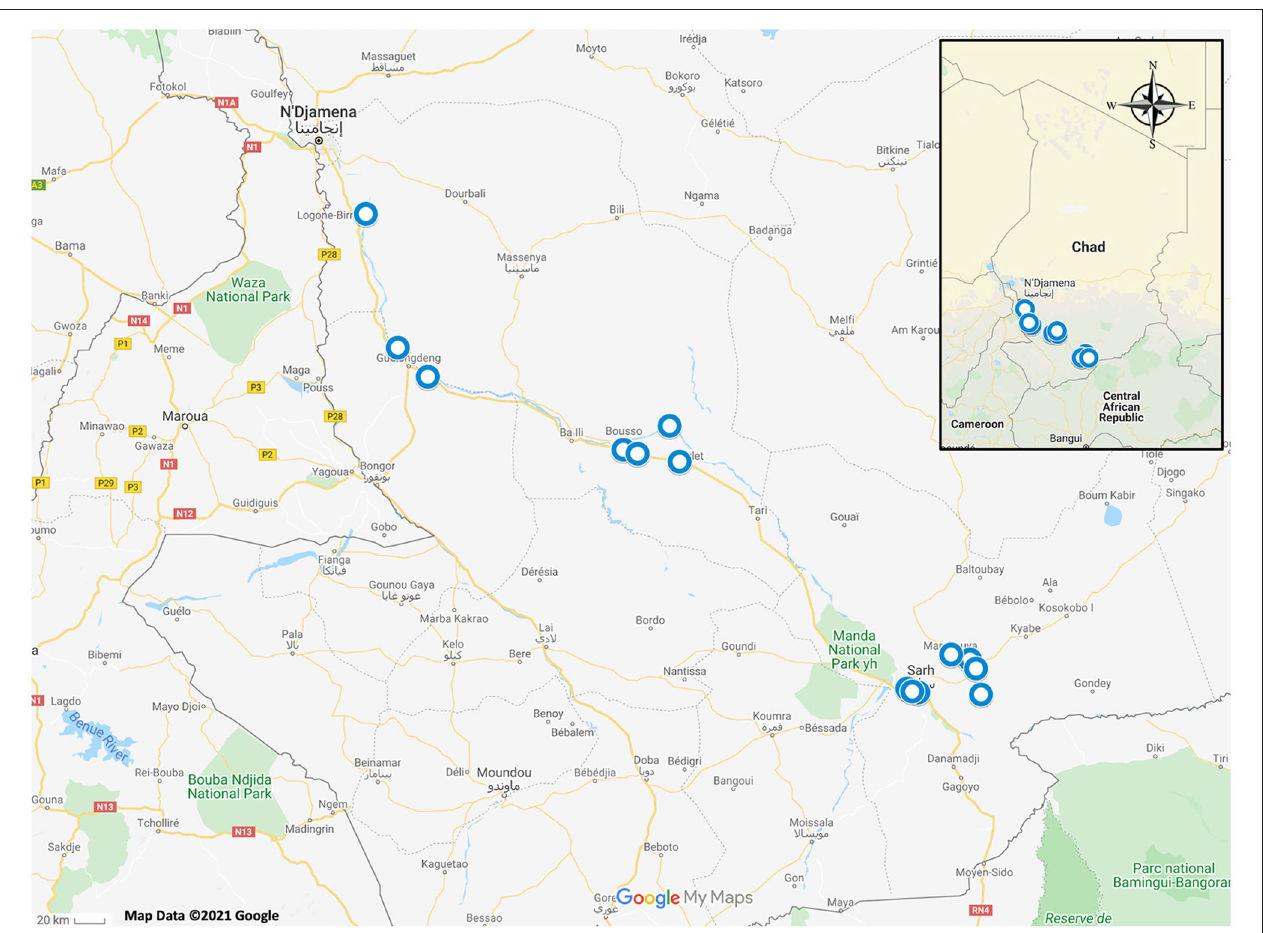
FIGURE 1 | Map of Chad, Africa with blue circles depicting sampling locations of amphibians and reptiles which were included in this study.